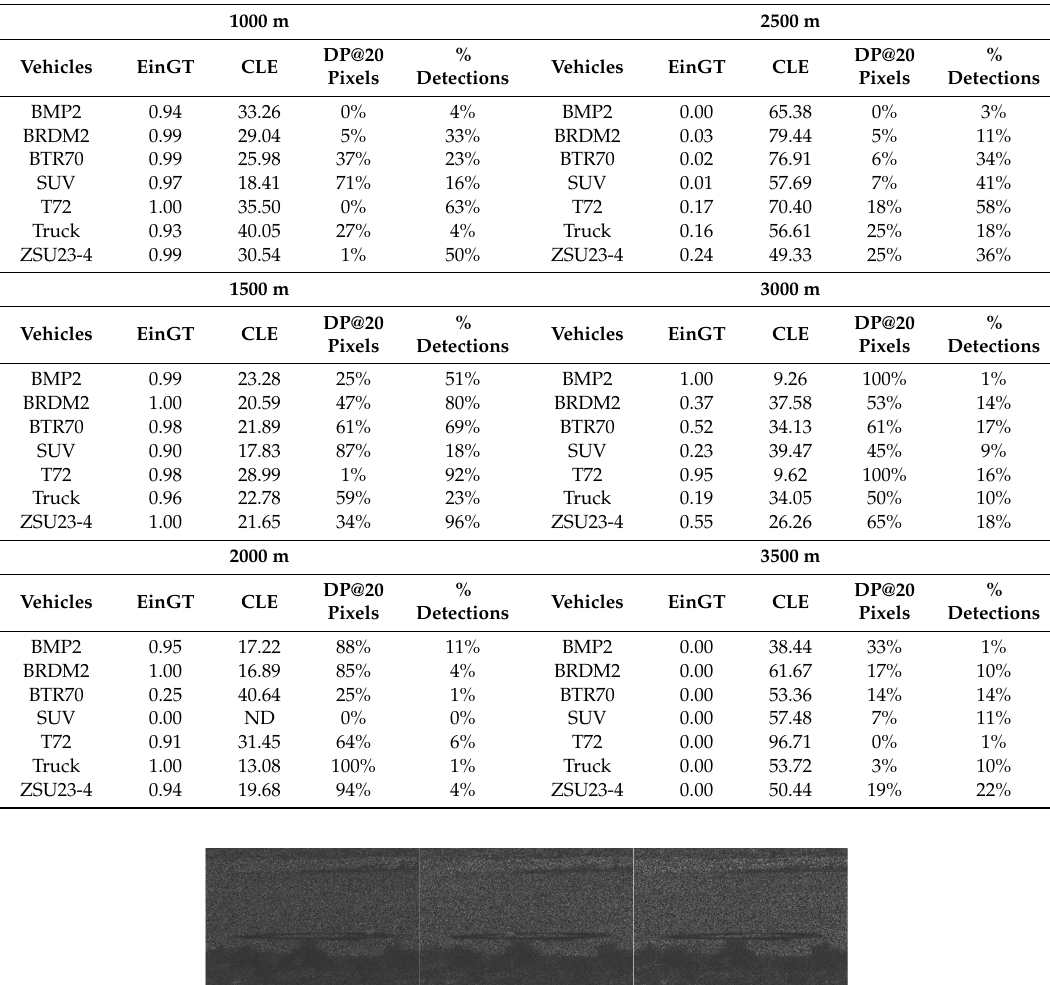
Table A6. Tracking metrics for PCE 25 (MWIR daytime) case. 1500 m and 3000 m were used for